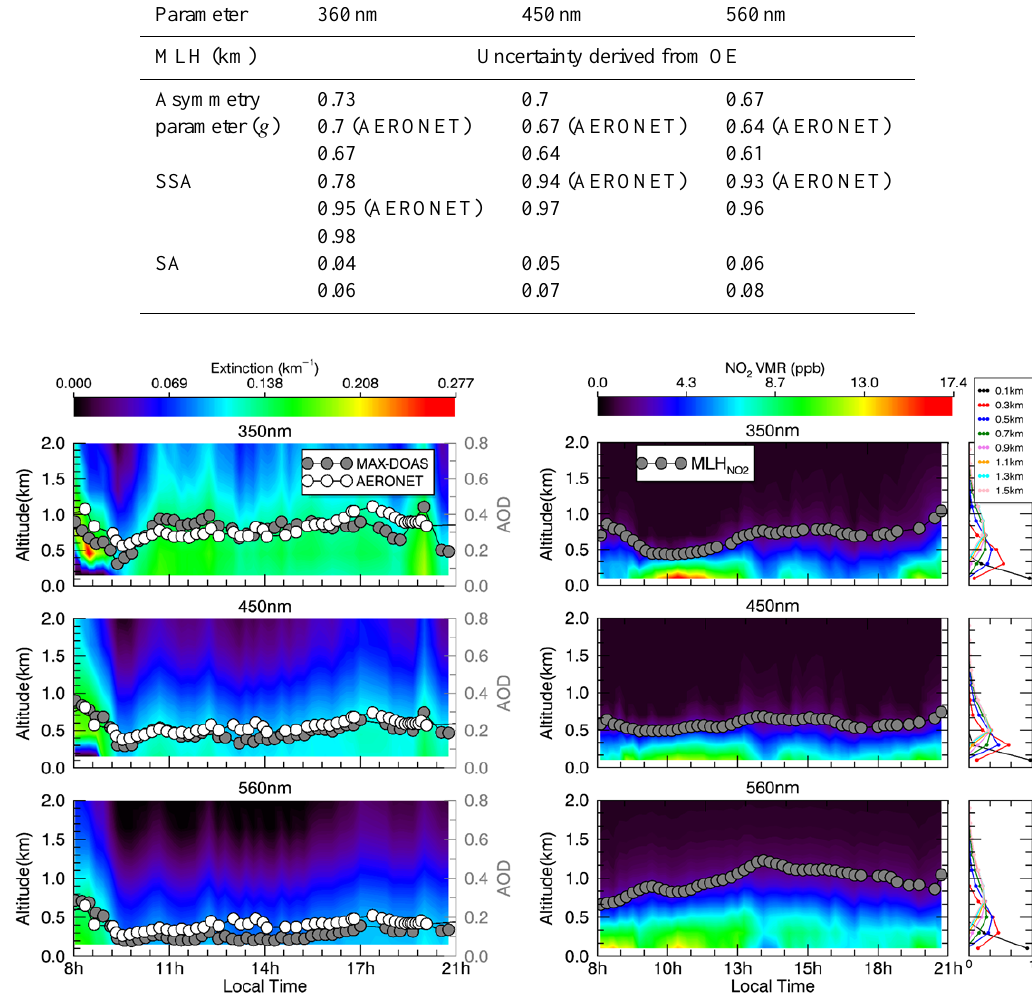
Figure 6. Diurnal aerosol extinction (left) and NO 2 vertical profiles (right) at three different wavelengths (from top to bottom: 350, 450, and 560nm) on Monday, 17 June 2013, above the MAD-CAT site for the standard AA of 50.8 ◦ . The AOD determined by MAX-DOAS at the O 4 wavelengths is compared with the AOD interpolated from co-located AERONET measurements which uses a different geometry (AOD towards the direction of the solar beam). The MLH NO is estimated as the 1 /( 2 e) decrease of the near-surface NO 2 VMR at each wavelength. 2 An averaging kernel example around midday is shown on the right plot of each NO 2 diurnal profile plot. The DOF for each case are ∼